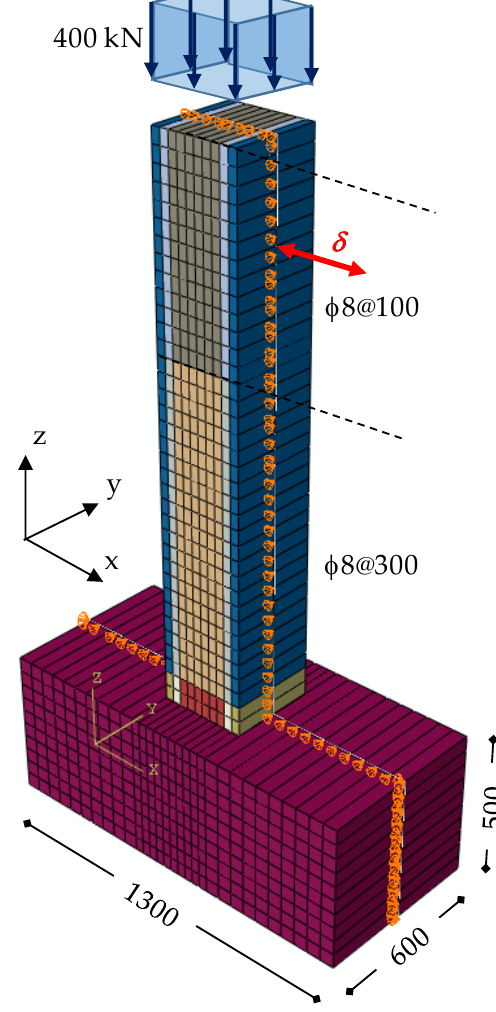
Figure 4. Geometry of the numerical model [mm].